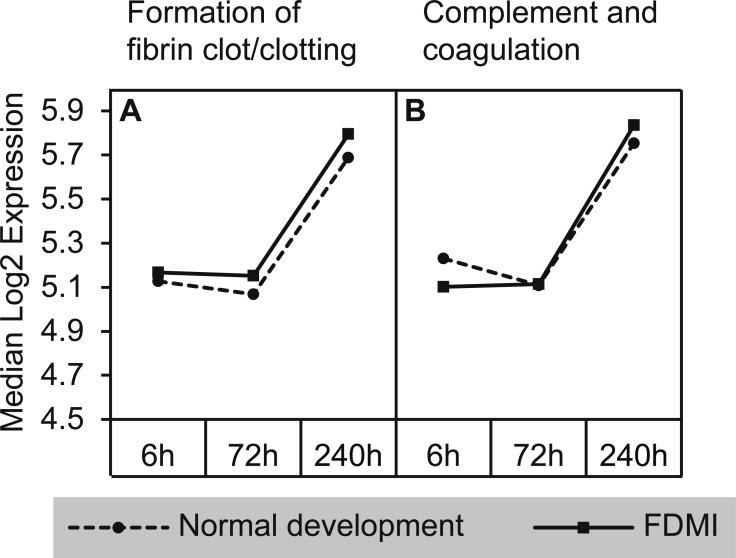
Median expression of pathways involved in the complement and coagulation cascade.Graphs indicate greater expression shift in the complement & coagulation cascade between 72 h and 240 h of occluder wear for both (A) formation of fibrin clot/clotting cascade and (B) complement and coagulation cascades. Note that the ‘complement and coagulation cascades’ pathway was also significantly altered during normal development.